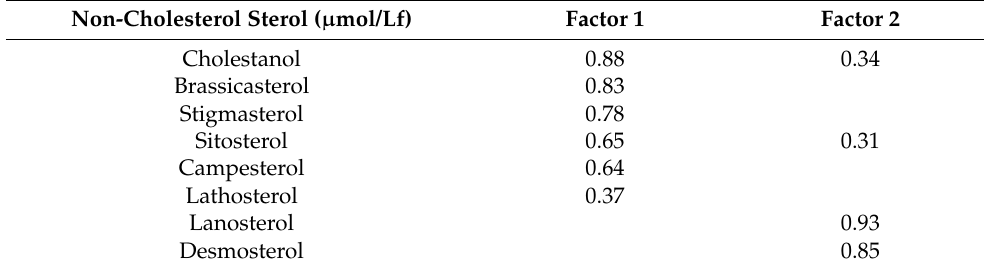
Table 2. Factor loadings after varimax rotation. Non-cholesterol sterol concentrations were corrected for